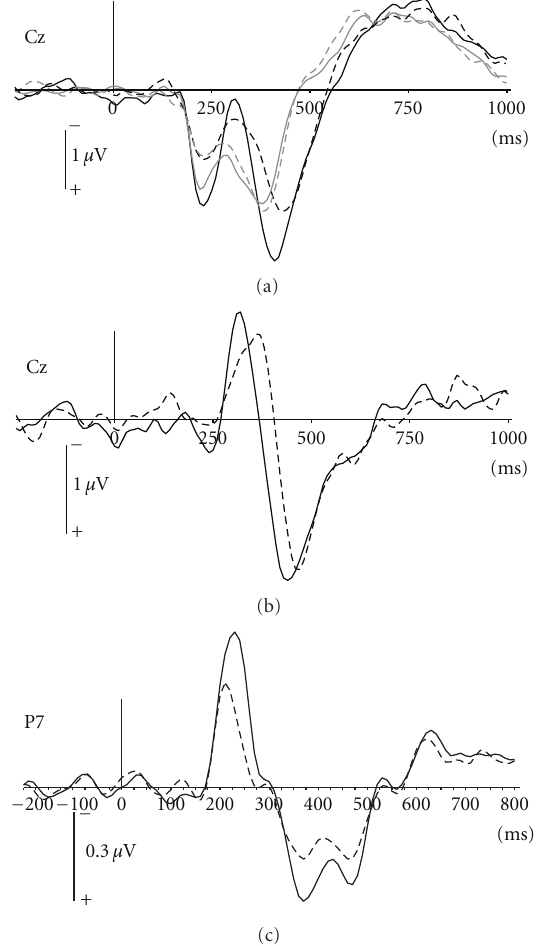
Figure 10: Grand average EEG event-related dynamics for group with a high specificity in solid line ( N = 10) and group with a low specificity in dashed line ( N = 6). (a) Responses to bad (grey) and good feedbacks (black) in channel Cz. (b) Di ff erence of bad and good feedback responses in channel Cz. (c) Di ff erence of target and non-target responses in channel